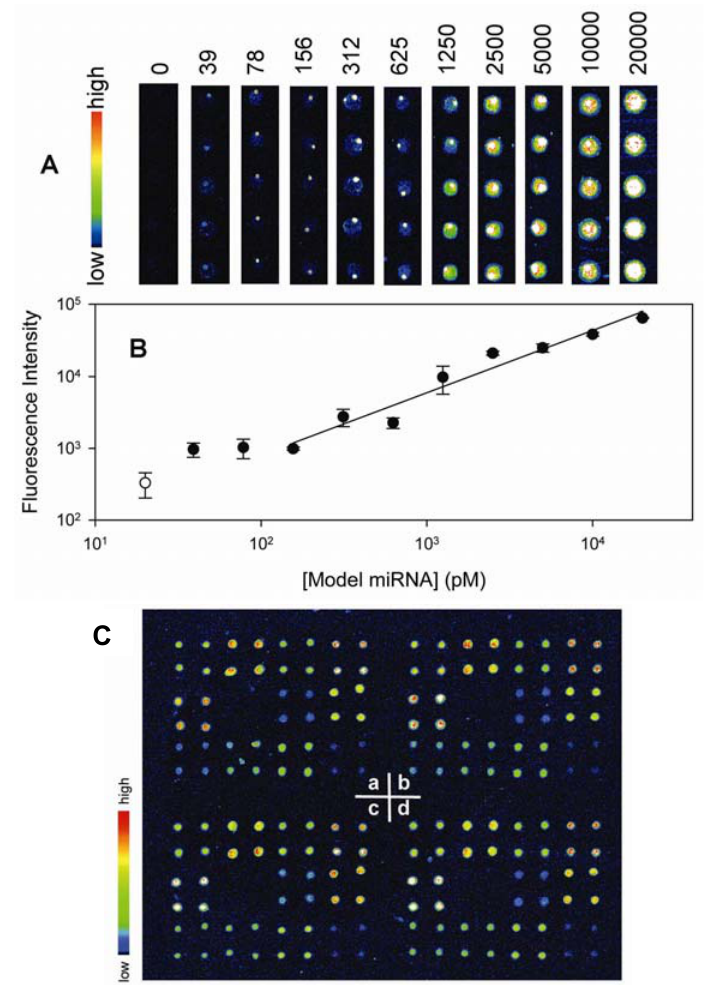
Figure 5. QD-Detection in miRNA Microrrays. A. Images of microarrays hybridized with various concentrations of miRNAs ranging from 20 nM to 39 pM. A 50 mM concentration of oligonucleotide probes was printed on slides in five replicate spots. Hybridization of the microarrays was carried out in a 10 ml volume. B. Correlation between fluorescence intensity of spots and the concentrations of model miRNA. The values were calculated from the image in A. Open circle represents the background. C. Image of 11 model rice miRNAs profiled on the microarray and detected with QDs. The microarray was hybridized with biotinylated miRNAs from rice seedling leaves. The center areas in each quadrant are the negative controls. Figures kindly provided by K-C Ruan (S.I.B.S.) and reproduced from [95] with permission of the Oxford University